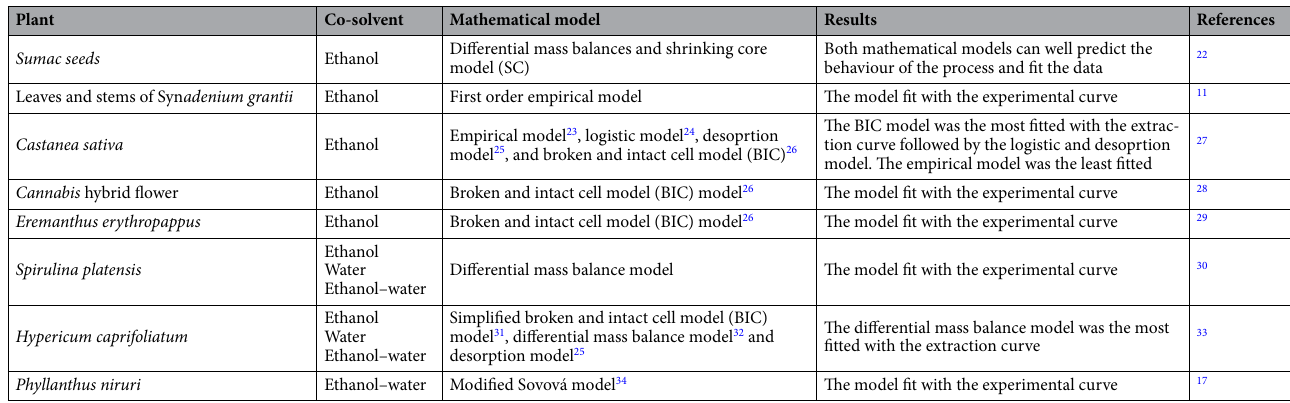
Table 1. Previous study on the mathematical models applied to SFE with a co-solvent for